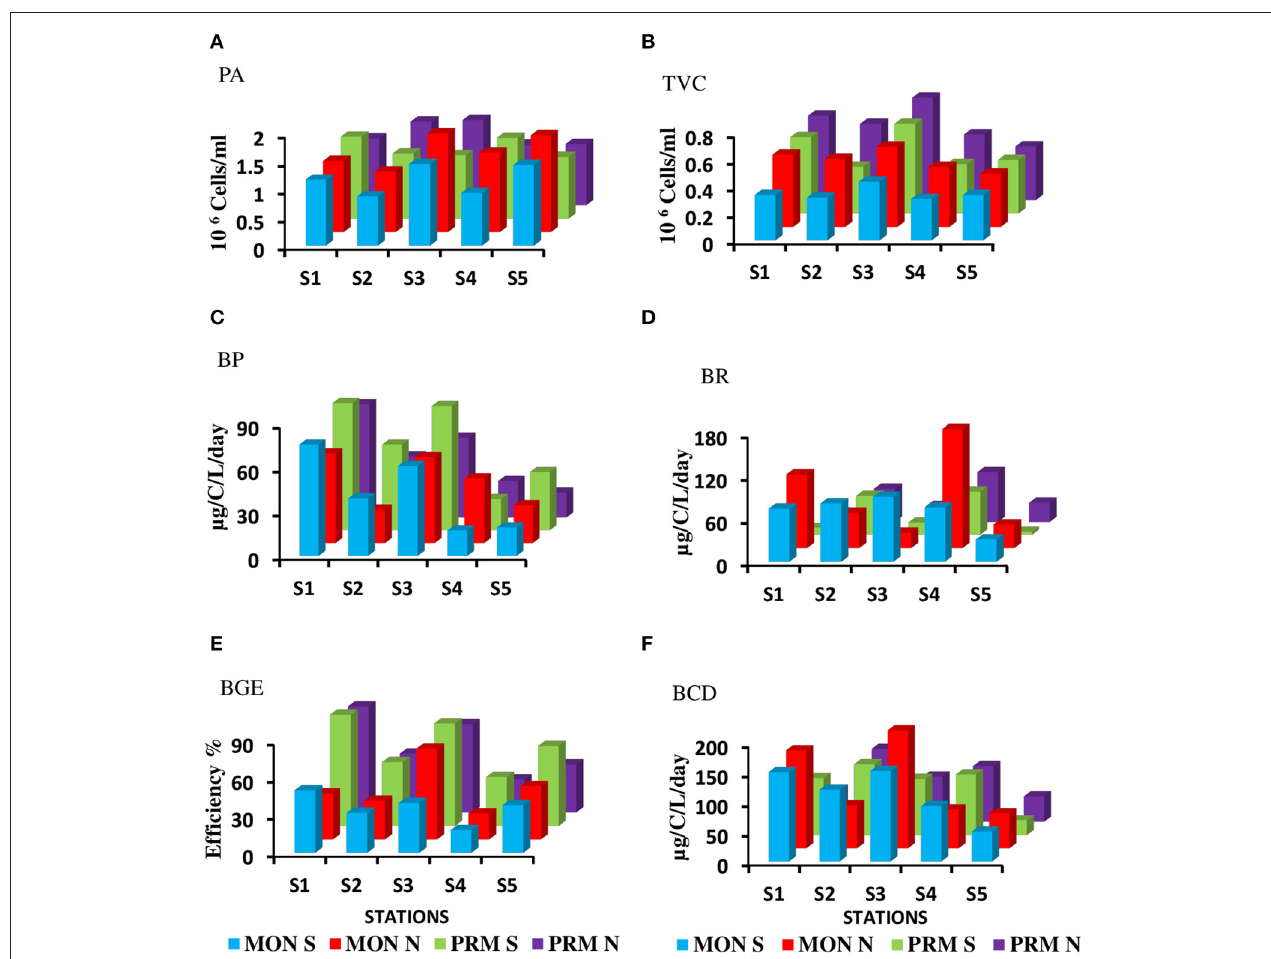
FIGURE 4 | Mean distribution of bacterial parameters during monsoon (MON) and Pre-monsoon (PRM) (A) Prokaryotic abundance in 10 6 cells/ml (PA) (B) Viable bacterial abundance in 10 6 cells/ml (TVC) (C) Bacterial production in µ g/C/L/day) (BP) (D) Bacterial respiration in µ g/c/l/day) (BR), (E) Bacterial growth efficiency % (BGE) (F) Bacterial carbon demand in ( µ g/c/l/day) (BCD). Spring and neap tide observations are denoted as S and N,